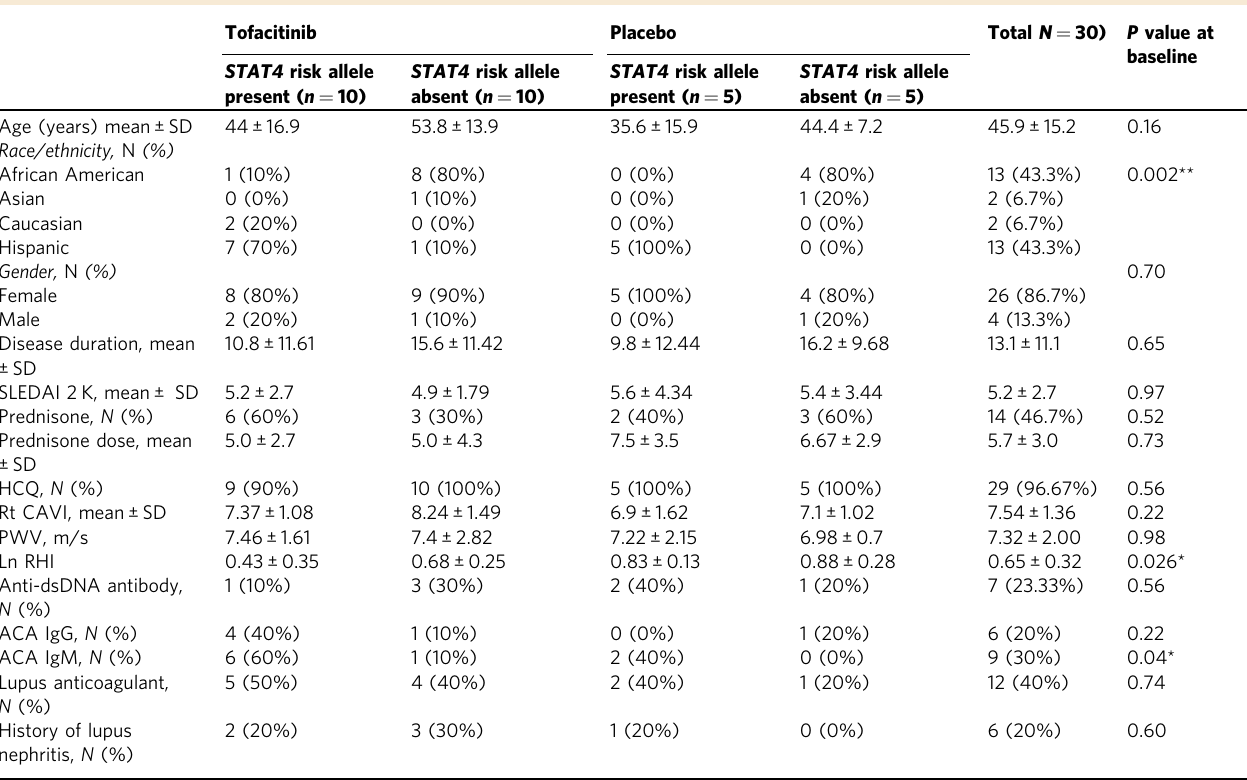
Table 1 Baseline demographic, clinical, and vascular characteristics of SLE subjects enrolled in the trial based on their STAT4 risk allele